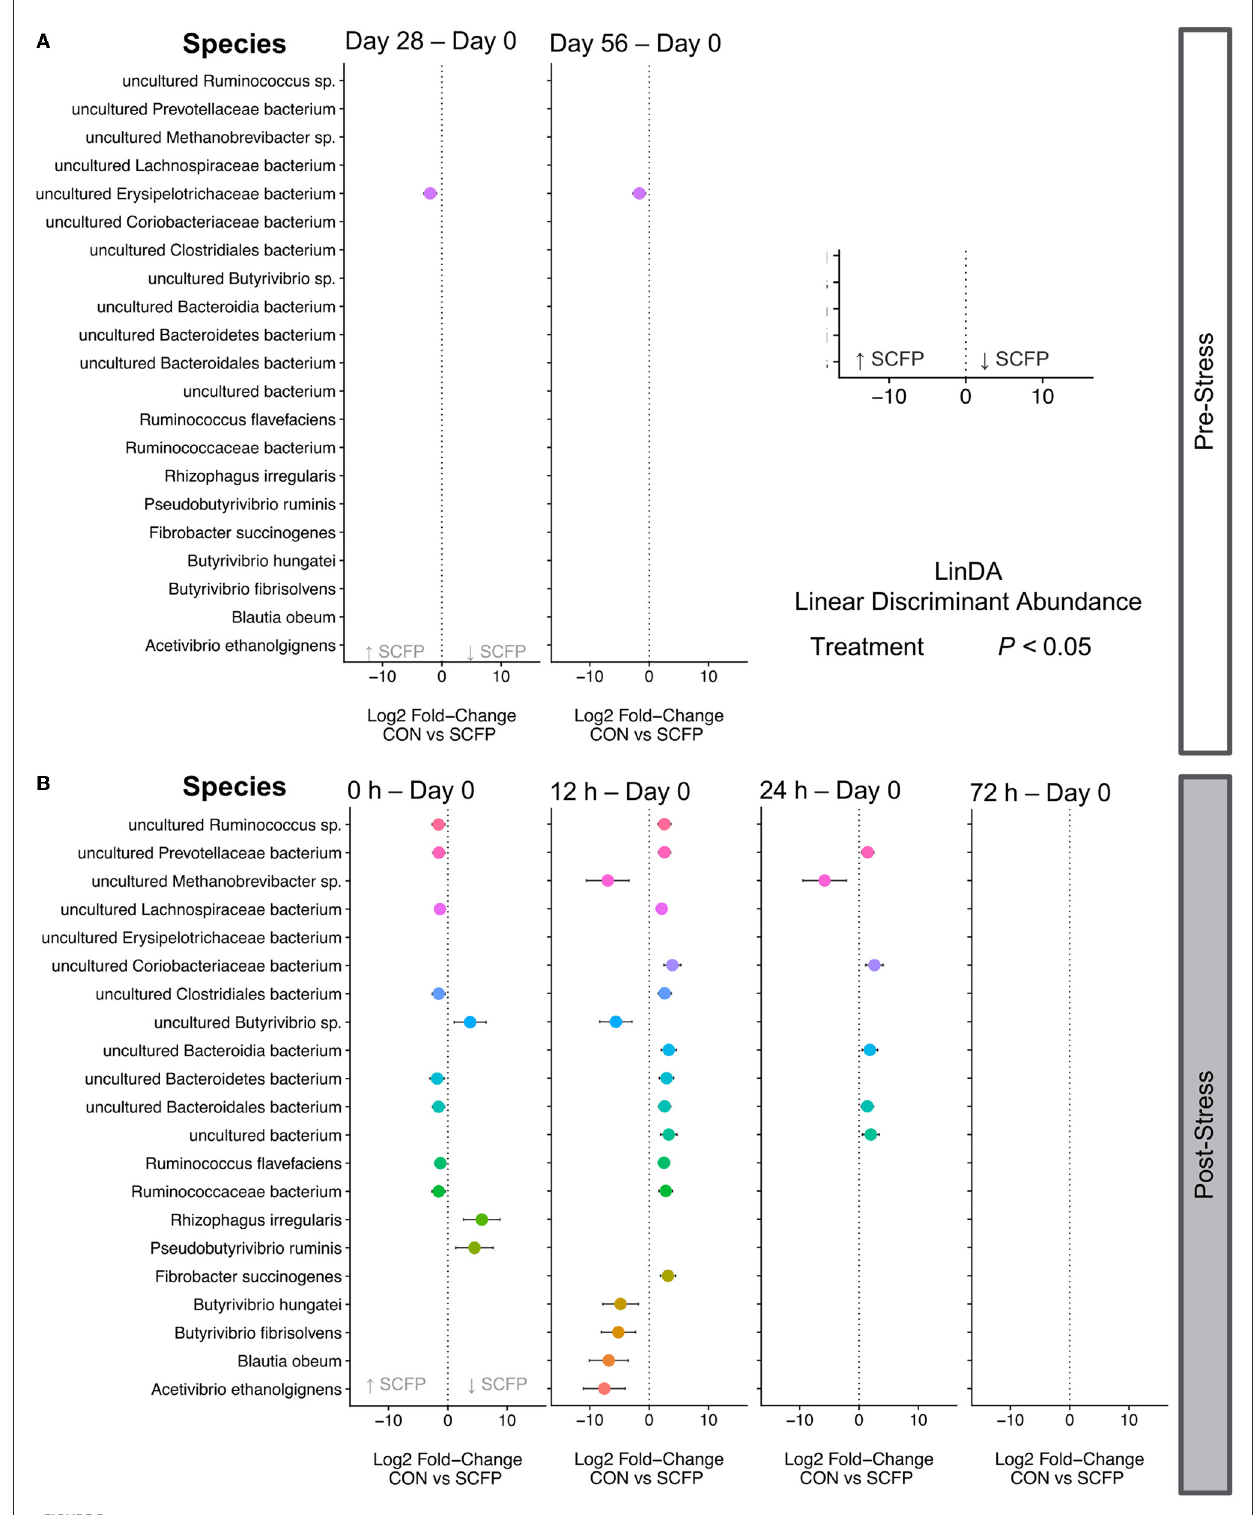
FIGURE5 Differential abundances. The effect size (log2-fold change) is shown for each species, and only significantly different species are shown in each plot with their correspondent confidence interval. Statistical models included relative abundance as the dependent variable, horse as a random effect, treatment, timepoint, and their interactions as independent variables. Multiple hypothesis testing correction was performed with Benjamini Hochberg False Discovery Rate method. A negative fold change indicates an increase in relative abundance in SCFP compared to Control, and a positive fold indicates a decrease in relative abundance in SCFP compared to Control. (A) Differentially abundant species before stress. (B) Differentially abundant species after